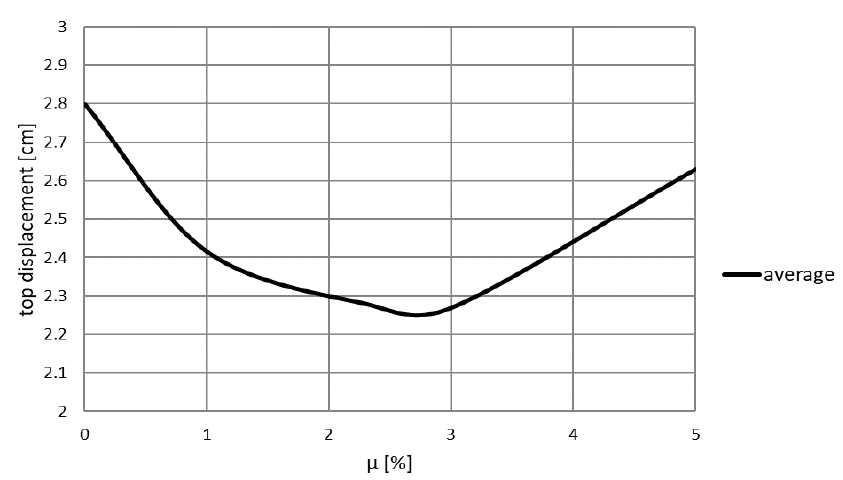
Figure 13. Top displacement against the mass ratio, μ considering the TMD positioned at 40.00 m.